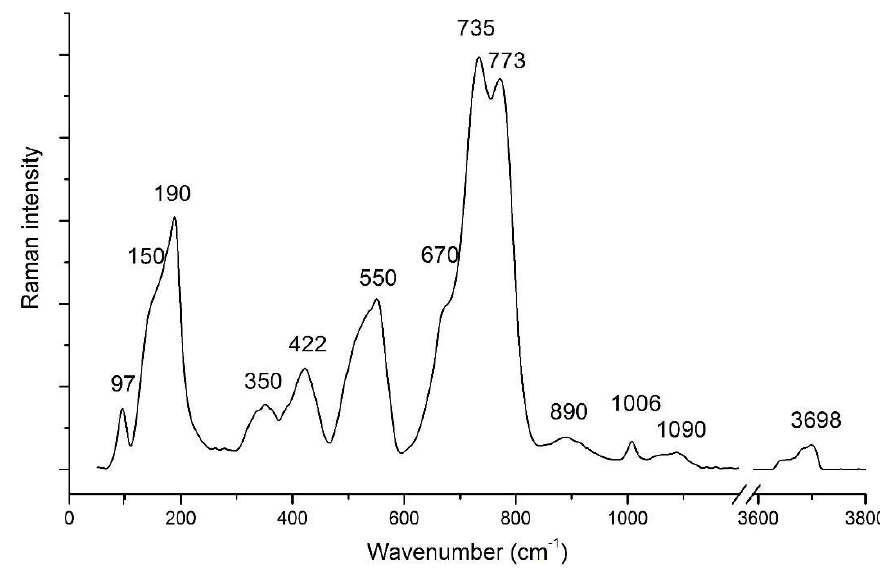
Figure 7. µ-Raman spectrum of the Ba–Ti phlogopite sample in the region 50–3800 cm −1 . Figure 7. µ -Raman spectrum of the Ba–Ti phlogopite sample in the region 50–3800 cm − 1